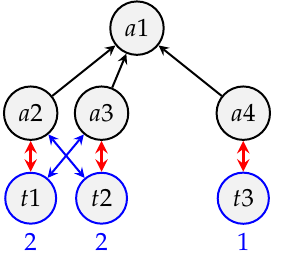
Figure 14. Routing graph G .